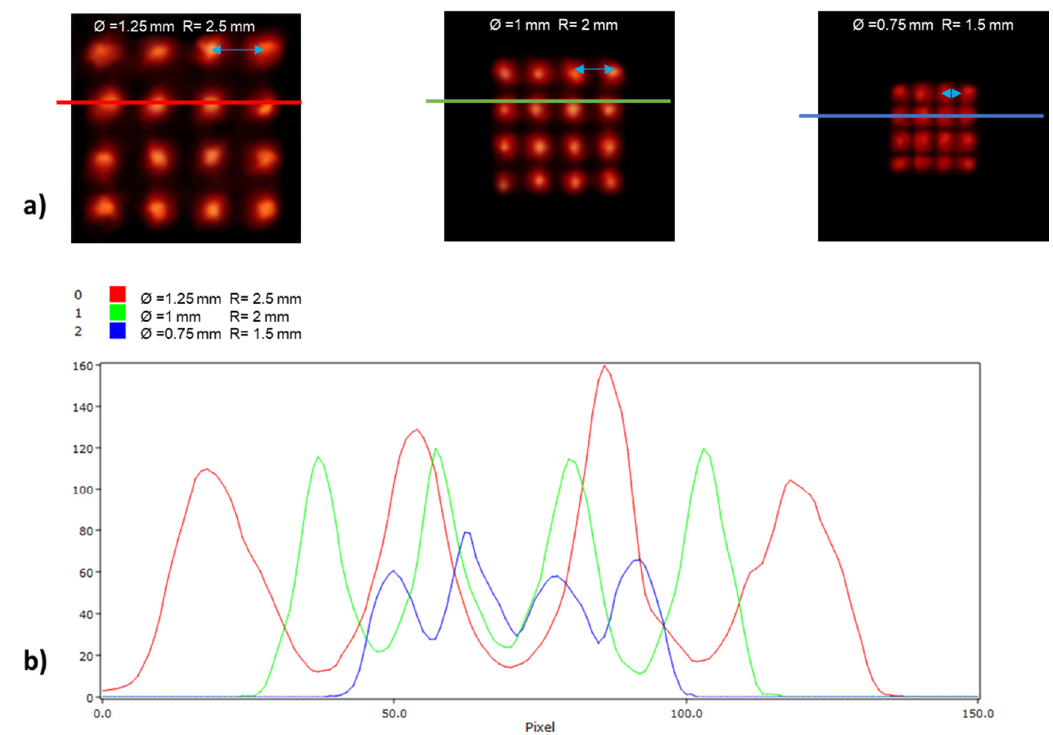
Figure 7. ( a ) Planar images and ( b ) line profiles of a grid containing 16 spherical sources with different diameters (from left to right: 1.25, 1 and 0.75 mm) and distances (from left to right: 2.5, 2, and 1.5 mm) for detector modules using the MLP positioning algorithm.